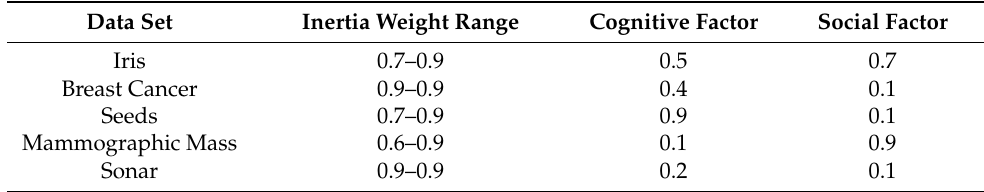
Table 1. Neural network with PSO parameter information. Data